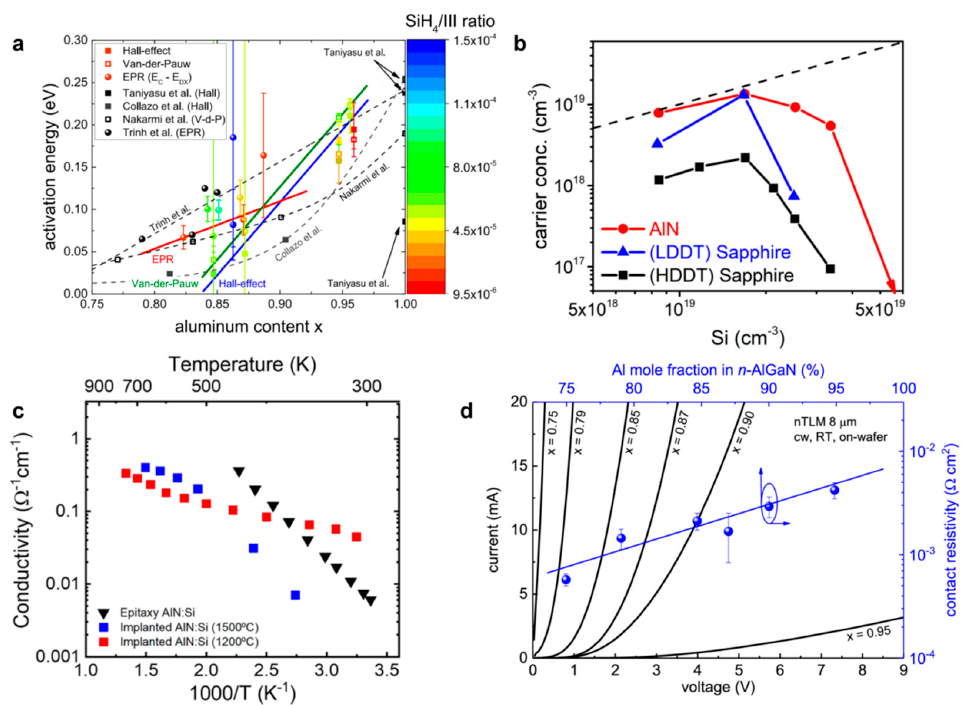
Figure 5. ( a ) The dependence of Si E a on Al composition [73]. ( b ) The conductivity of n-AlGaN on different substrate with increasing Si doping concentration [74]. ( c ) Temperature dependent conductivity for the epitaxially doped AlN film, the Si-implanted AlN film on sapphire, and the Si-implanted AlN film on AlN substrate [79]. ( d ) IV curves and contact resistivity for n-contacts on n -AlGaN as a function of Al mole fraction [ Error! Reference source not found. ].